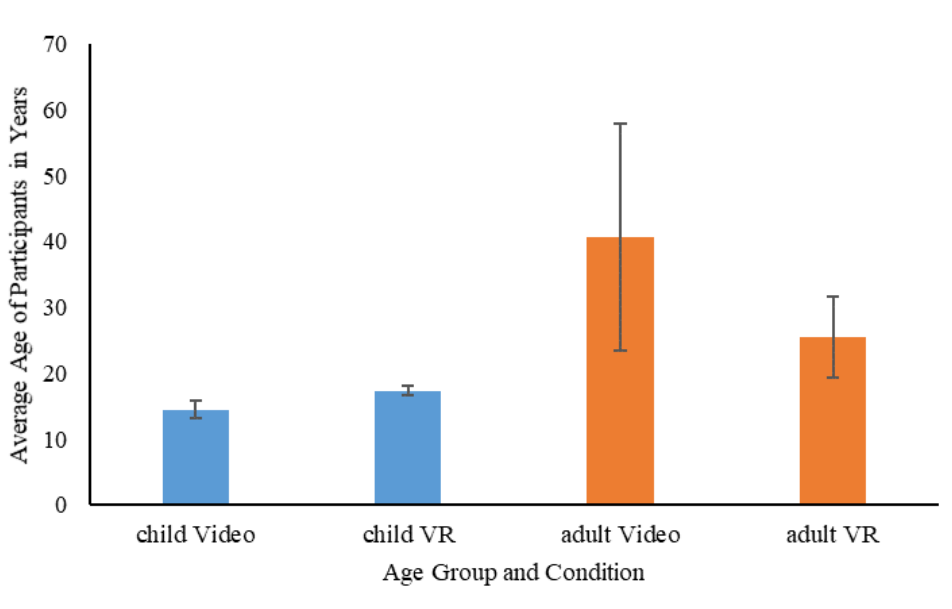
Average Age of Participants in the VR and Video